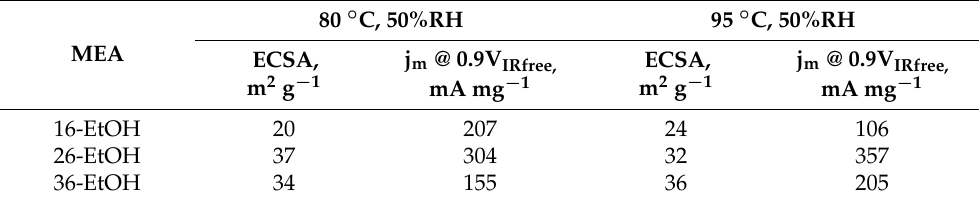
Table 3. Electro-kinetic parameters for developed MEAs with different ionomer amounts.